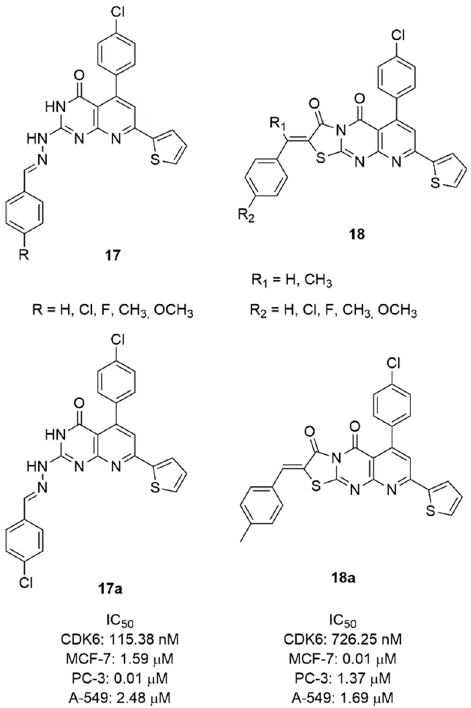
Figure 9. CDK6 inhibitors based on the pyrido-pyrimidine scaffold.